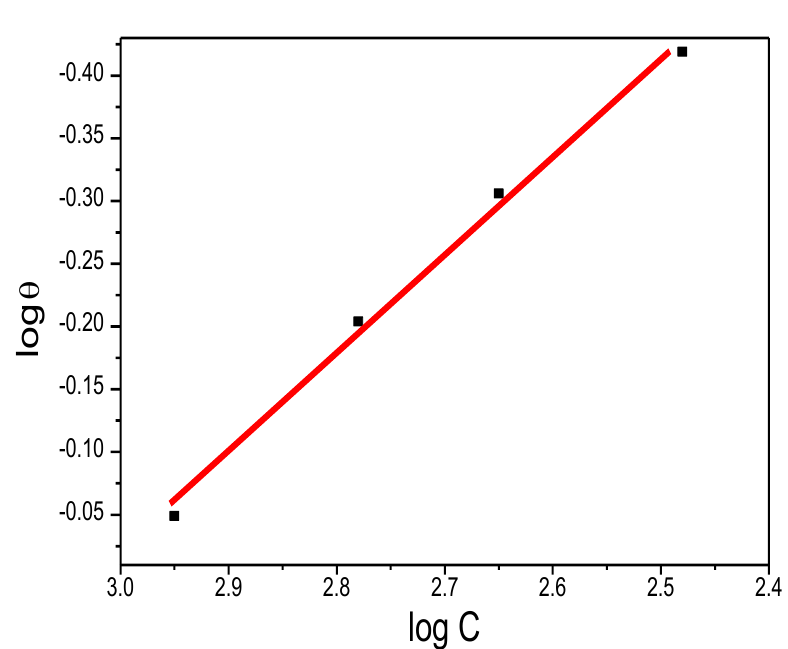
Figure 6. Freundlich adsorption isotherm curve fitting of corrosion data for aluminum in 1 M HCl in the presence of varying concentrations of honey inhibitor.